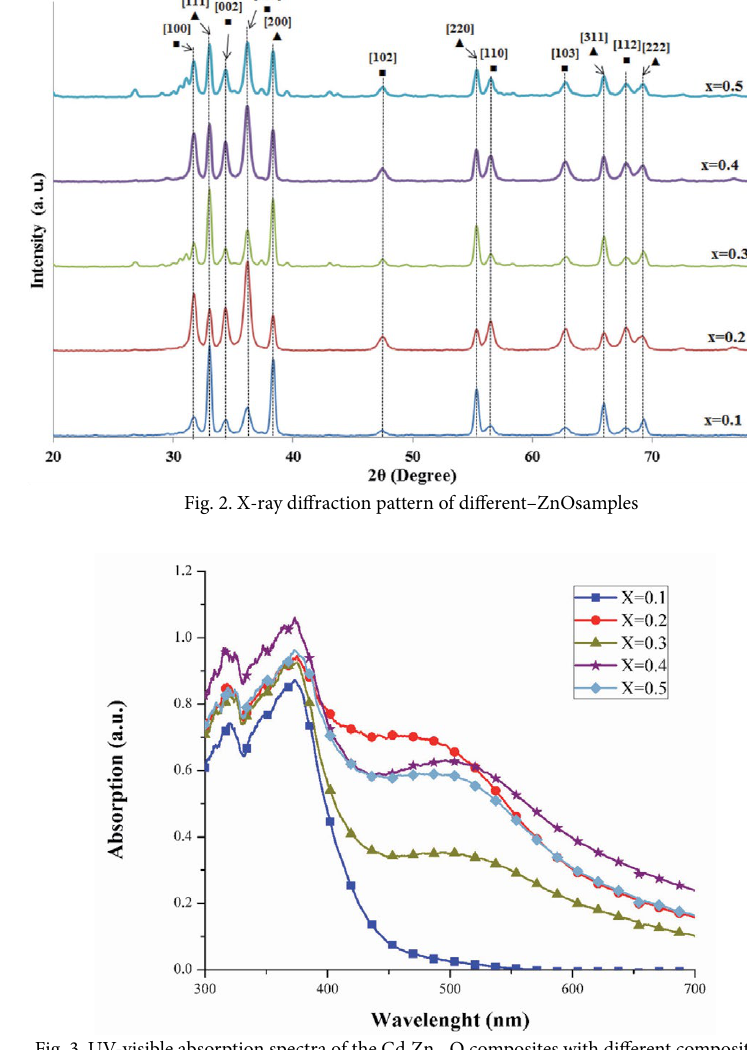
Zn O composites with different x 1-x